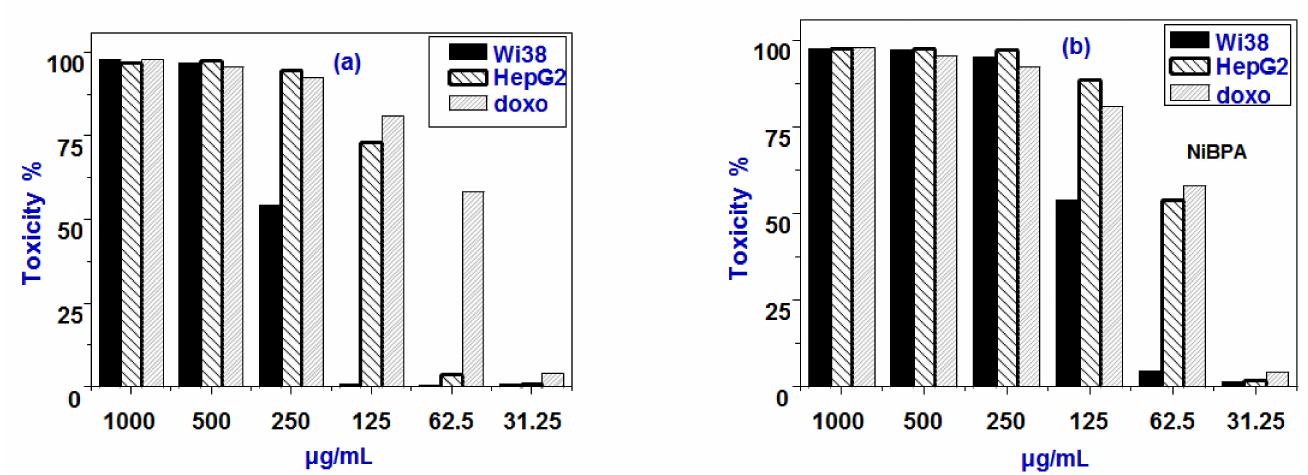
Figure 10. In vitro cytotoxicity of ( a ) BPA and ( b ) NiBPA against different concentrations.